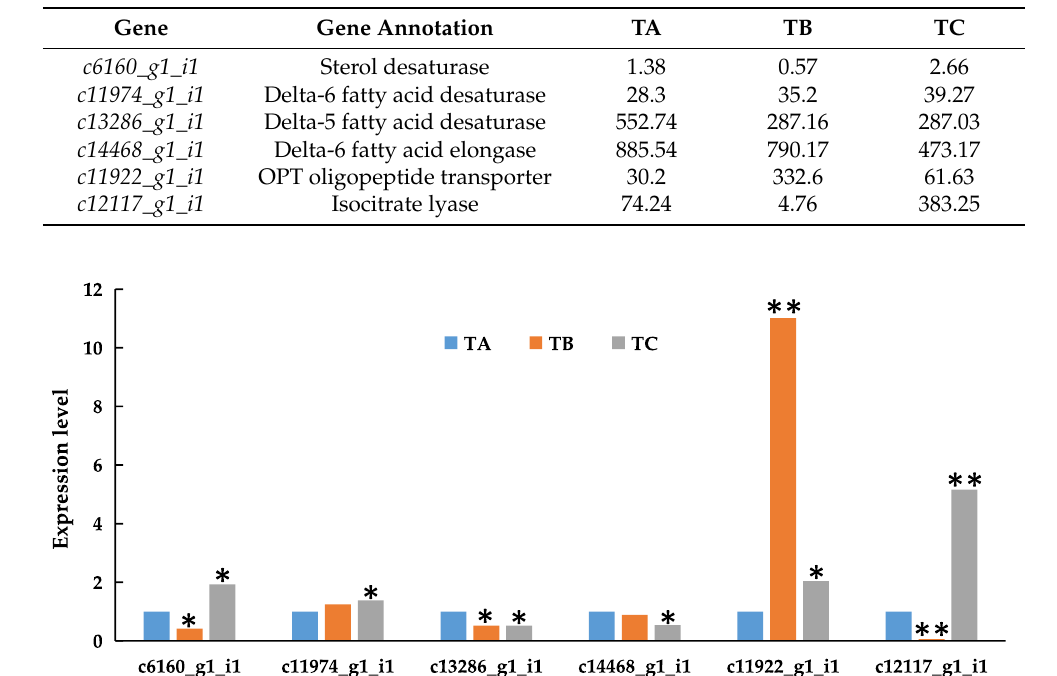
Table 6. Expression profiles presented with values of the fragments per kilobase of transcript per million mapped reads (FPKM) of six differentially expressed genes (DEGs) of three groups of Mortierella alpina (TA, TB, and TC) randomly selected for the qRT-PCR analysis. Gene annotation is based on the non-redundant (Nr) database at the National Center for Biotechnology Information (NCBI).